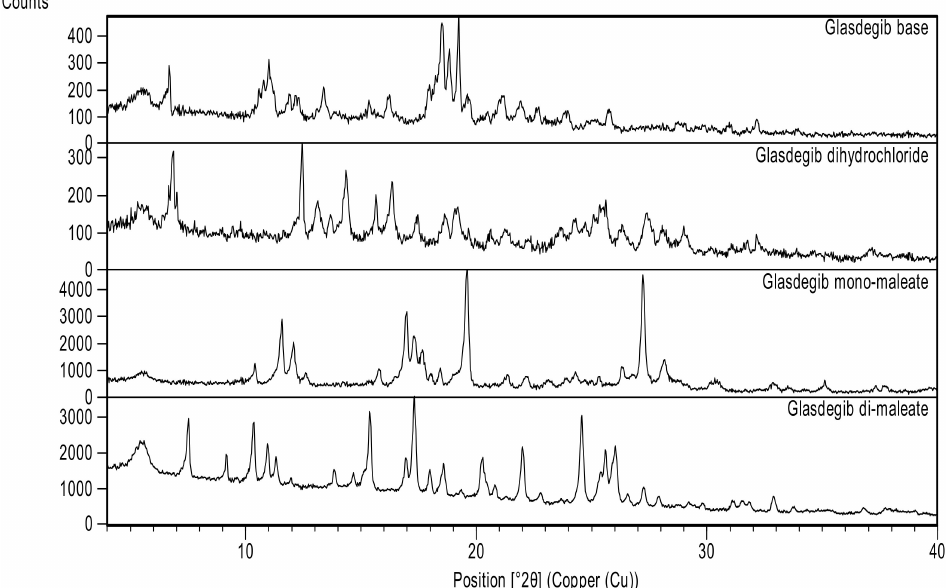
Figure 2. Powder X-ray diffraction patterns of glasdegib derivatives: glasdegib base, glasdegib dihydrochloride, glasdegib monomaleate and glasdegib